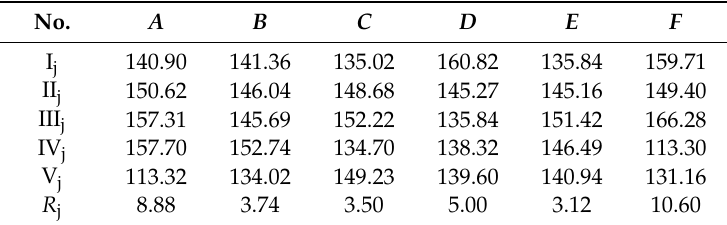
Table 7. Data table of deposition e ffi ciency range analysis (deposition e ffi ciency /